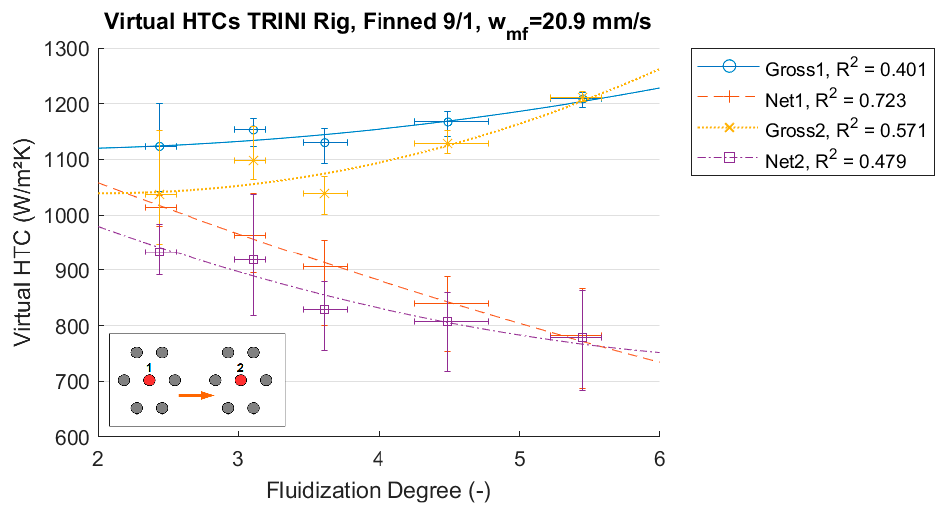
Figure 16. Results of helically finned tubes, pitch 9 mm, fin thickness 1 mm, TRINI test rig, 146 µm particles. Indices 1 and 2 refer to the different heated tubes.